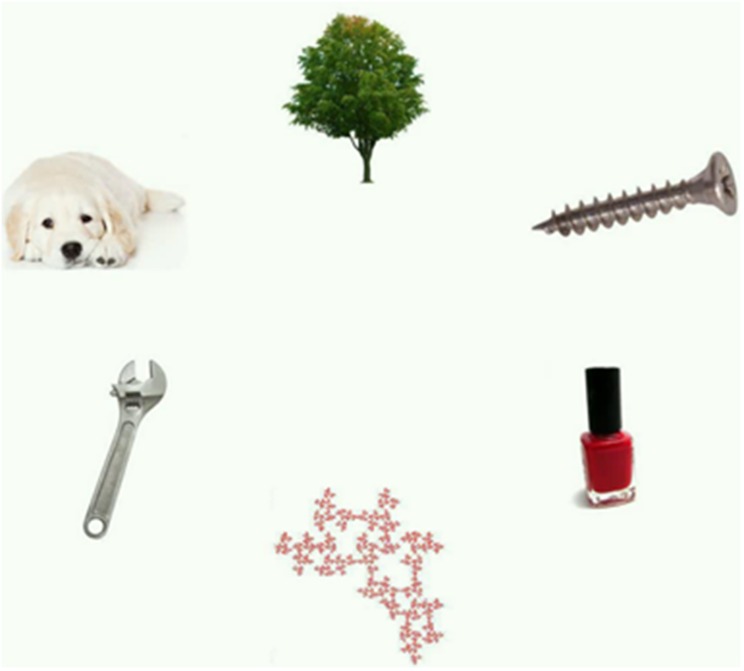
Sample array of objects shown in Experiment 2. Infants viewed a total of 48 arrays for 4 s each. Infants' fixations to each object were recorded.